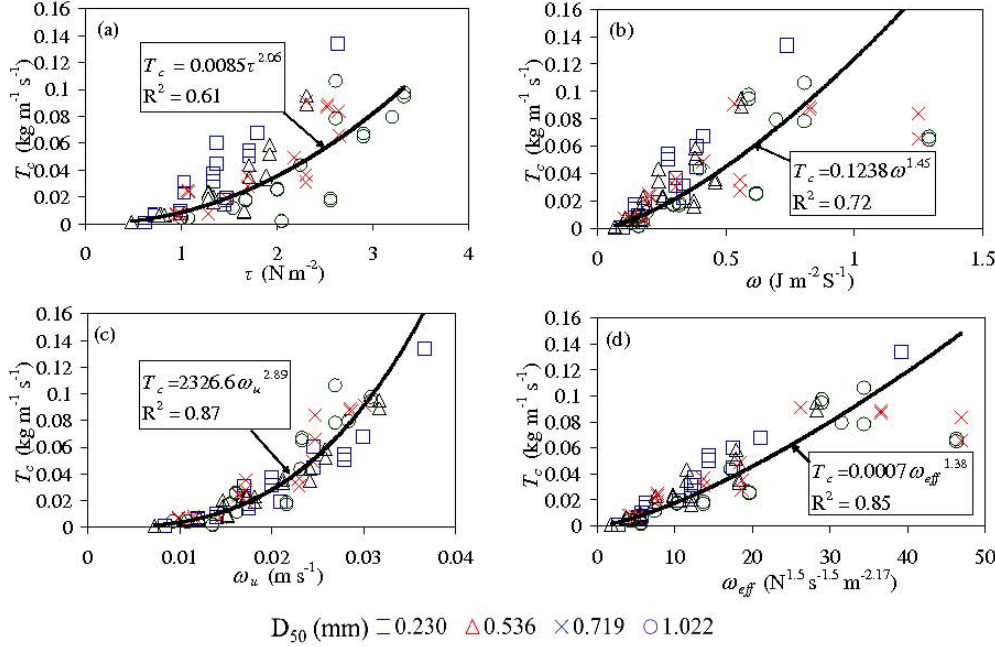
Fig. 5. Sediment transport capacity ( T c ) as a function of (a) shear stress, τ ; (b) stream power, ω ; (c) unit stream power, ω u ; (d) effective stream power, ω eff for four grain sizes.